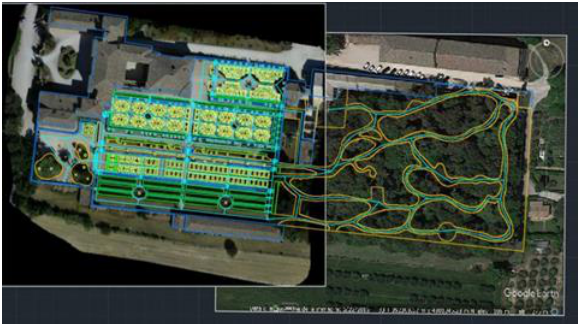
Figure 11. Query selection related to a statue with some multimedia